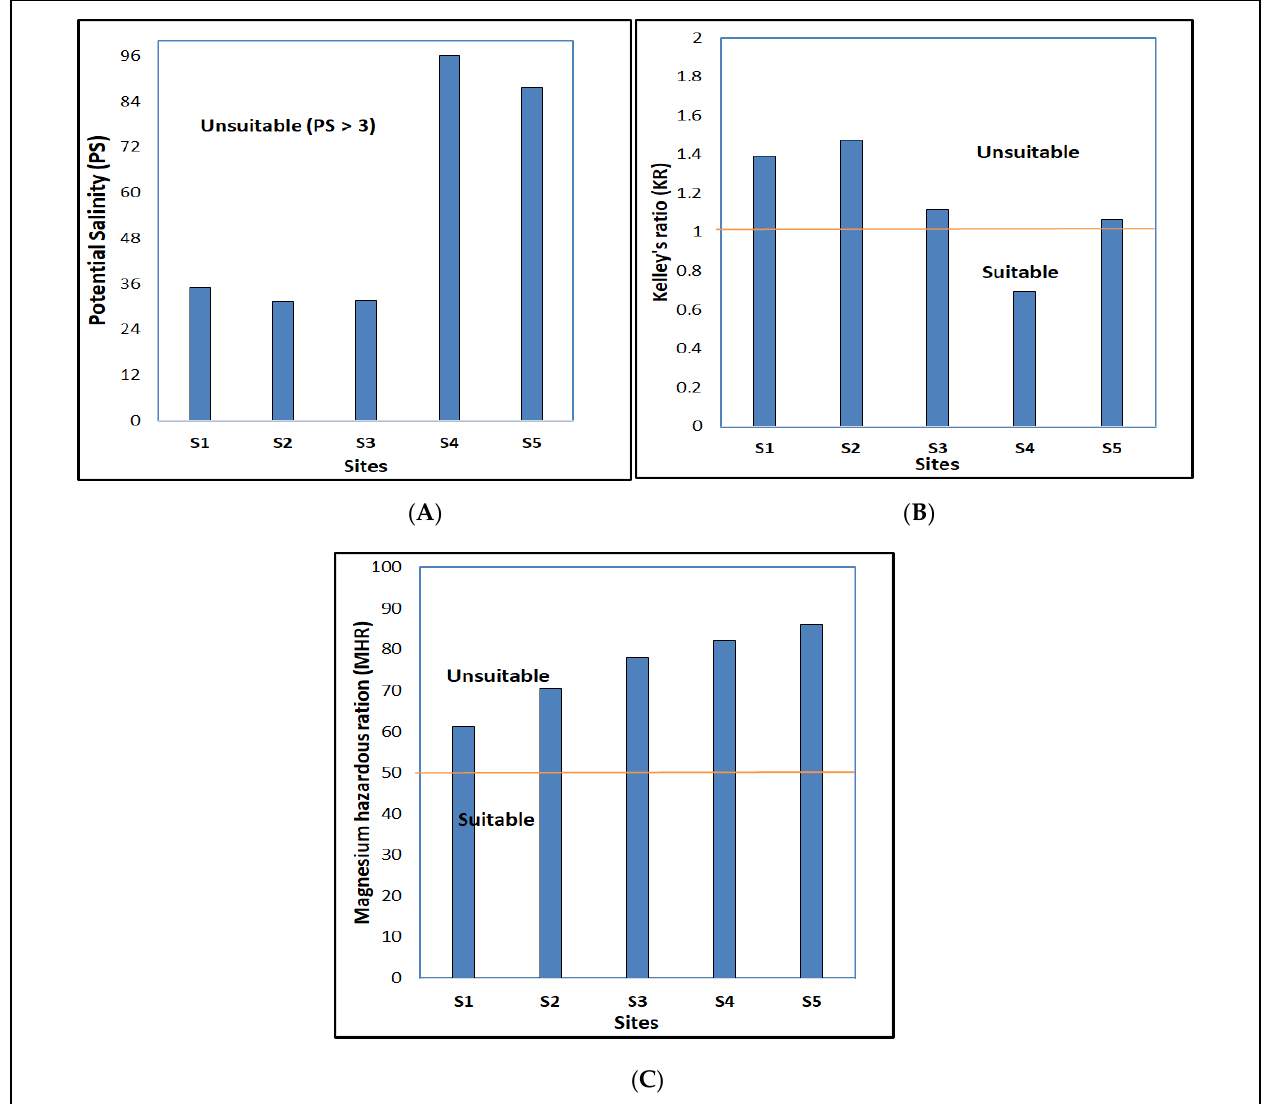
Figure 10. Irrigation quality indices for the groundwater samples. ( A ). Potential salinity (PS) > 3, unsuitable; ( B ). Kelley’s ratio (KR) < 1 suitable, KR > 1 unsuitable; ( C ). Magnesium hazard ratio (MHR) < 50 suitable, MHR > 50 unsuitable.